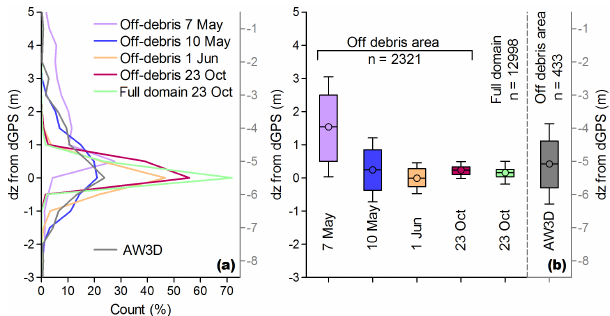
Figure 4. Evaluation of DEMs, expressed as (a) histogram and (b) box plot of elevation difference from dGPS data (dz, vertical axes). Evaluation was performed over the off-debris area (Fig. 2a), at which no/less debris was found, while “full domain” denotes the whole area at which both elevation data of UAV DEM and dGPS were obtained during our in situ observation in October 2015. The cell size of the DEMs is 1m except for that of the AW3D (5m). Also note the bias in the AW3D (left axes). Box, line, and circle in the box-and-whisker plot denote interquartile, median and mean, and 1 standard deviation,